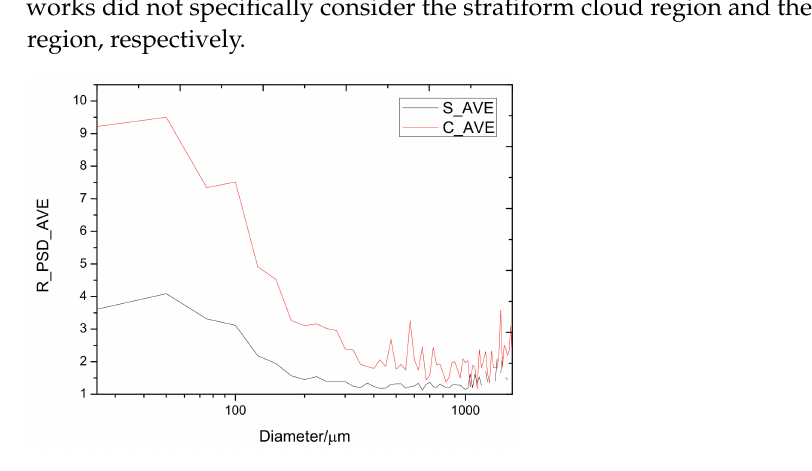
Figure 5. Ratio of the average distribution of the cloud particle number concentration with diameter in different cloud types.